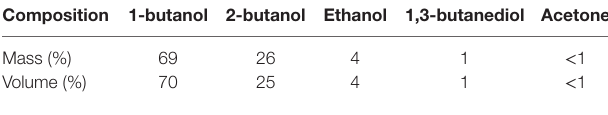
TaBle 1 | Composition of total product mixture, determined by 1 H NMR, 400 MHz, CDCl